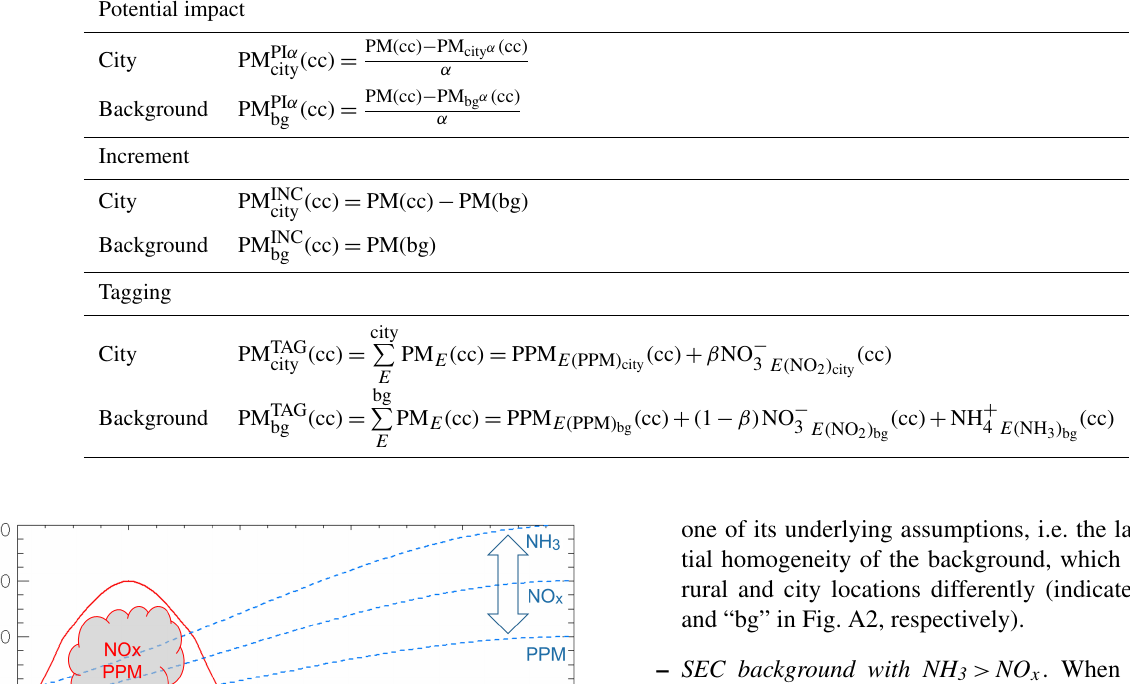
Table A1. Formulations for the potential impacts, increments, and tagging approach for the example presented in Fig. A1. The indicator for all methods and components is the total particulate matter mass (PM). The SA method is indicated as superscript (PI α , INC, or TAG), whereas the source (city or bg) is in subscript. The receptor is the city centre (cc), while the rural location selected for the increment approach is denoted by “bg”. For the tagging, the source subscript is also expressed directly as emissions ( E ) distinguishing each compound (within brackets).